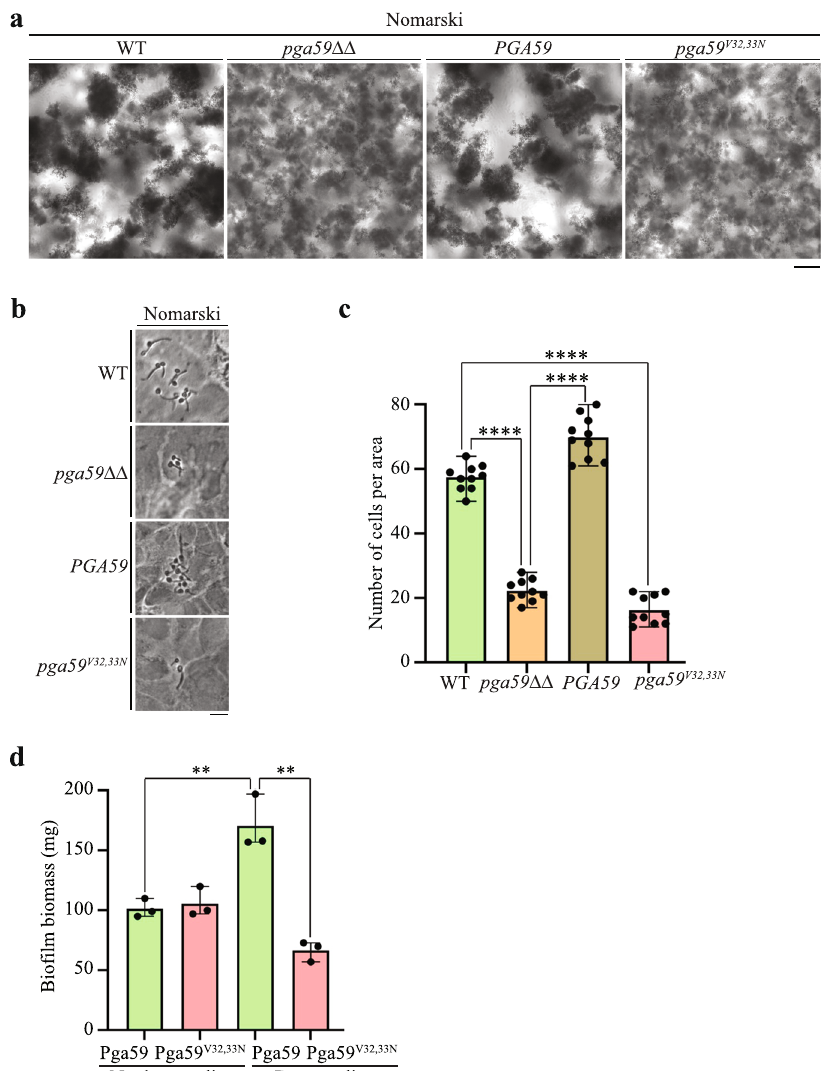
Fig. 6 Pga59 V32,33N impairs adhesion on biotic and abiotic surfaces as well as bio fi lm establishment in C. albicans . a Adhesion to abiotic surfaces was assessed by cultivating the indicated strains with magnetic beads. The formation of cellular aggregates was assessed by transmission microscopy (Nomarski). Scale bar: 200 μ m. b The indicated strains were cultivated on a monolayer of Caco-2 cells to monitor adhesion on biotic surfaces. After 1 h of adhesion, C. albicans cells were washed and observed under the microscope (Nomarski). Scale bar: 10 μ m. c C. albicans adhered on Caco-2 cells were counted on 200 µm 2 areas. The experiment was repeated three times. Signi fi cance was assessed using Student ’ s t -test. (****) p < 0.0001. d Bio fi lms of the indicated overexpression strains were grown in a continuous fl ow microfermentor in a GHAUM medium in the presence or absence (negative control) of 50 μ g mL − 1 doxycycline. After 40 h, the bio fi lms were detached from the spatula, dried for 24 h, and weighed. The histogram presents the quanti fi cation of data derived from three independent experiments. Values are the average of each condition ± SD. (**) p < 0.01. The signi fi cance of the dry mass differences between the conditions was assessed using Student ’ s t -test. Source data are provided as a Source Data fi